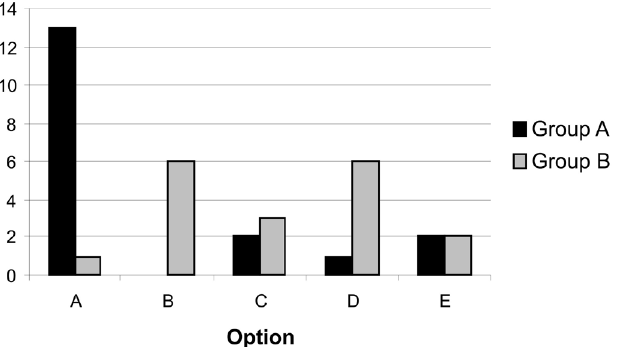
FIGURE 2 - Distribution of answers on question 13 for both